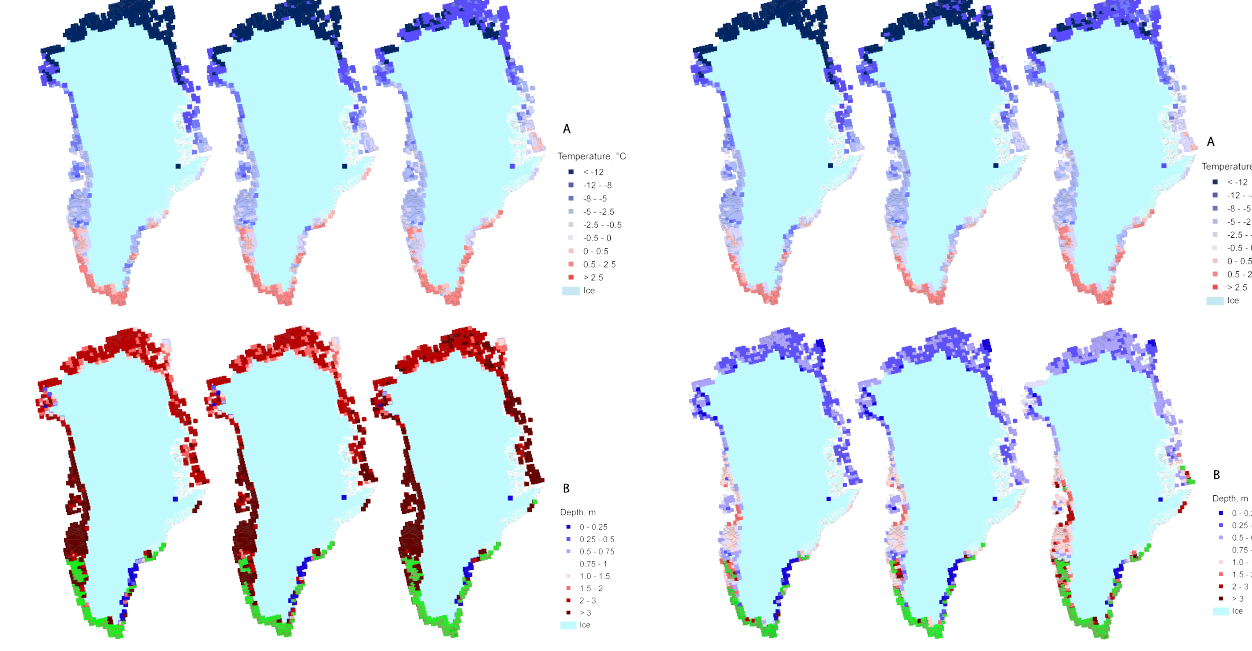
Fig. 4. (A) Bedrock temperature distribution at 2m depth for an average over the periods 1955–1965, 1995–2005, and 2065–2075. (B) Active layer depth distribution in bedrock for an average over the periods 1955–1965, 1995–2005, and 2065–2075. The green color represents a permafrost free zone.